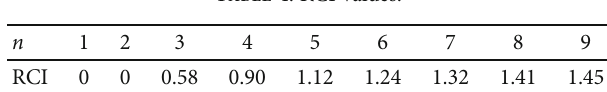
Table 4: RCI values.